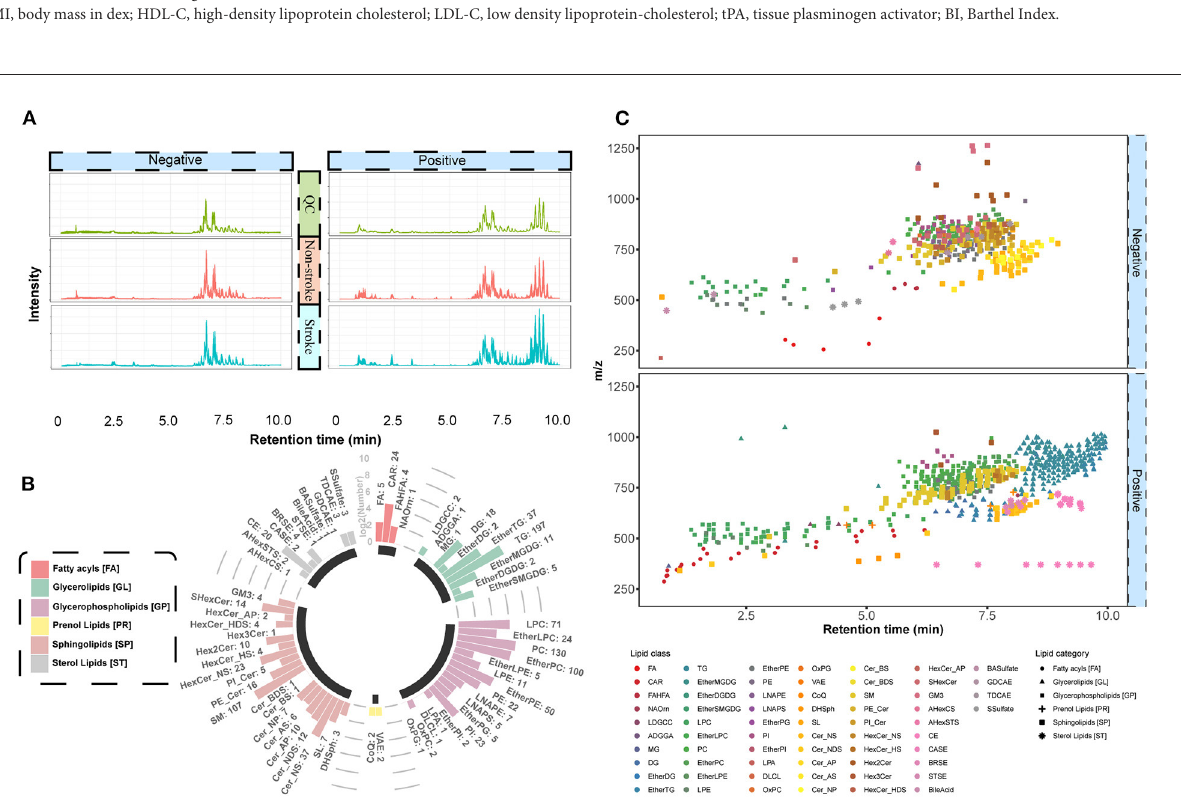
FIGURE2 Quality assessment for lipids. (A) Total ion chromatogram of all samples. Negative and positive ion modes are illustrated in the left and right panels, respectively. Four colors correspond to four types of samples, including QC, non-stroke, and stroke groups. The X -axis displays the amount of time (min) for the ions to pass through the column. The Y -axis displays the peak area based on the number of ion counts taken by the mass spectrometer detector at the retention point. (B) Circular bar plot for identified lipids. The lipid species fall into six main categories with different colors. The numbers next to the lipid species name represents the number of lipid features that have been identified. (C) Spatial distribution and elution order for all detected lipids, plotted against their respective retention time (min) and m / z . The color of the peak spots indicates the lipid species, and the shape of the peak spots indicates six main lipid